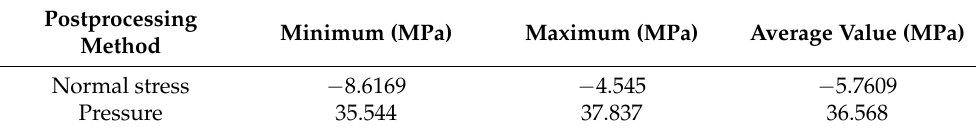
Figure 10. ( a ) Normal stress graph of geometric interference; ( b ) result of geometric interference pressure. Maximal, minimal, and average values of interface pressure are shown in Table 6. Table 6. Results of contact interference setting